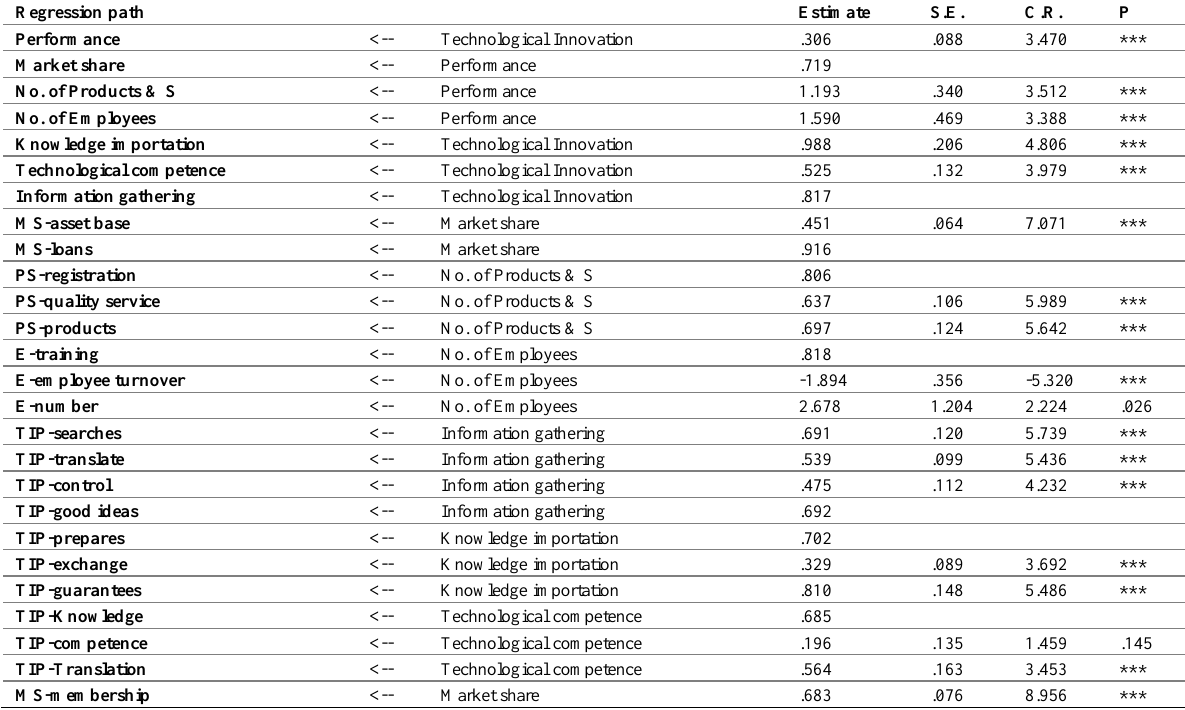
Table 7: Regression Weights/ Technological Innovation Promoters on